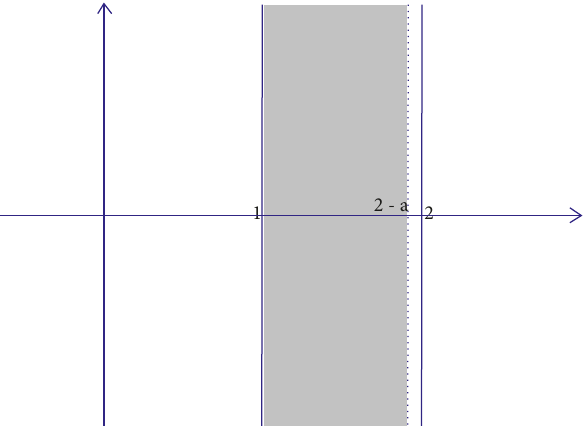
Figure 2: Zero-free region for fractional hypergeometric zeta function of order a .